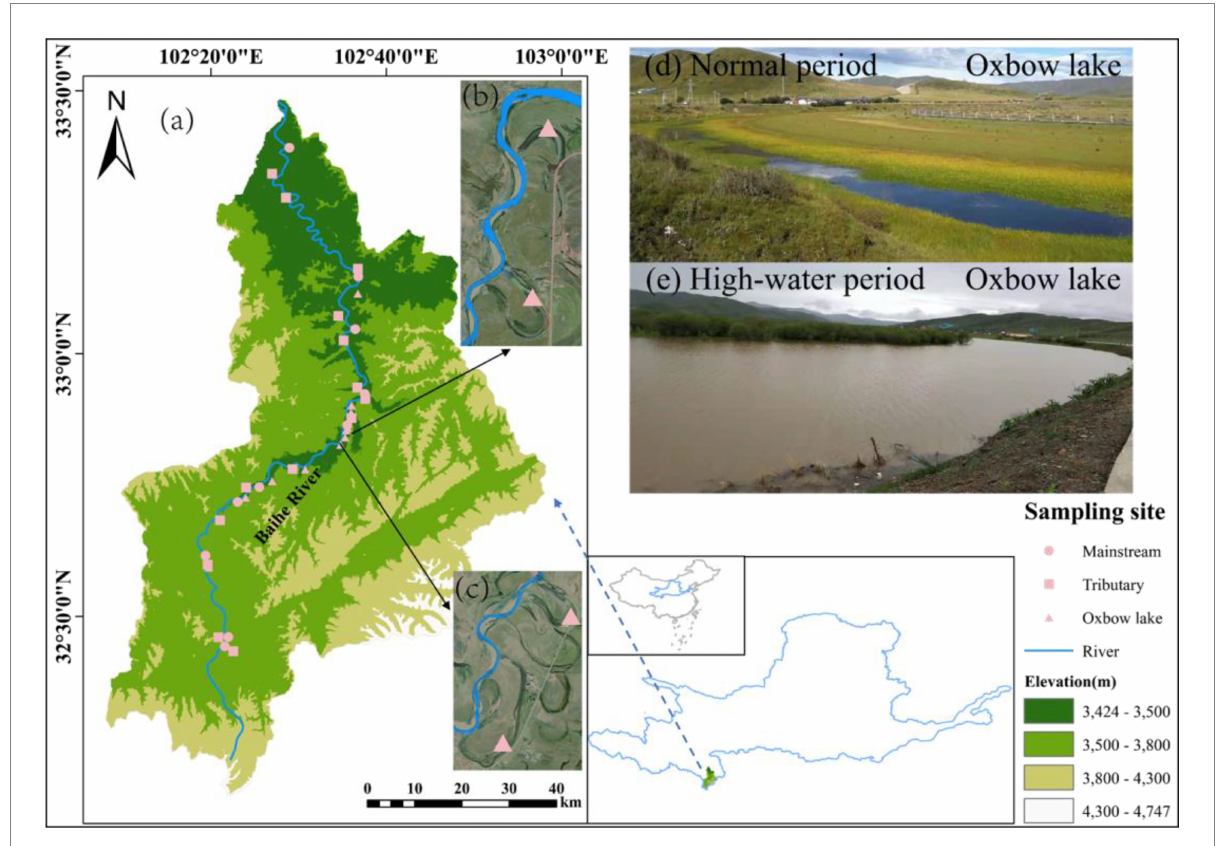
FIGURE 1 Locations of sampling sites in Baihe River in the source region of the Yellow River, China. (A) Baihe River Basin. (B) Sampling sites at oxbow lakes 5 and 6. (C) Sampling sites at oxbow lakes 7 and 8. (D) Oxbow lake in normal period. (E) Oxbow lake in high-water